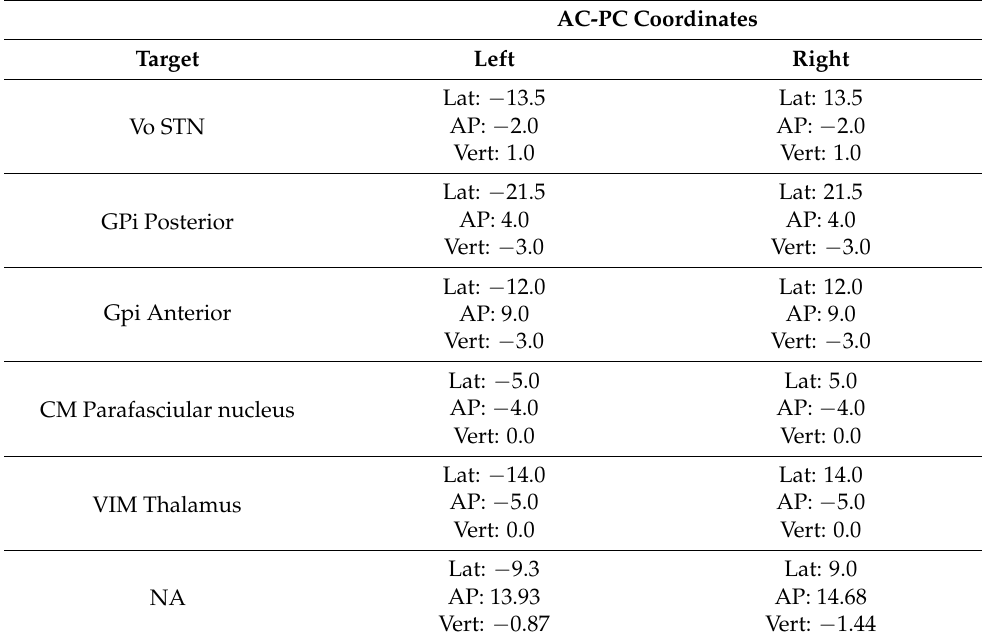
Table 1. Target coordinates relative to AC-PC midpoint of temporary Adtech stereo EEG leads. AC-PC